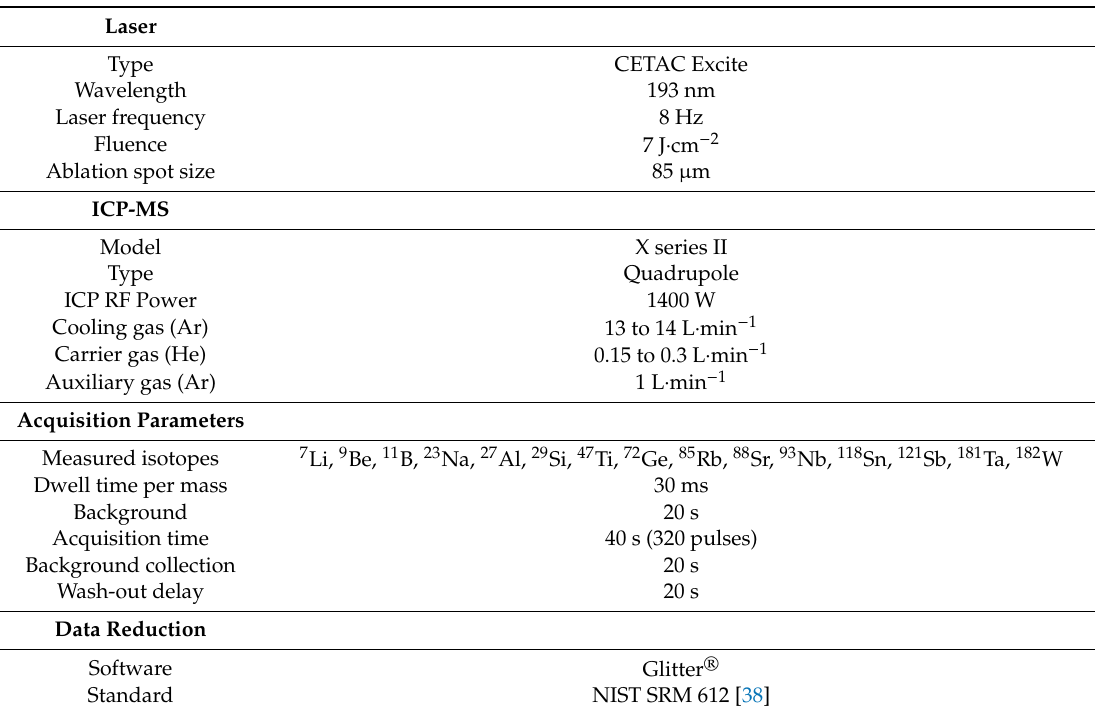
Table 1. Laser ablation-inductively coupled plasma-mass spectrometry (LA-ICP-MS) protocol and